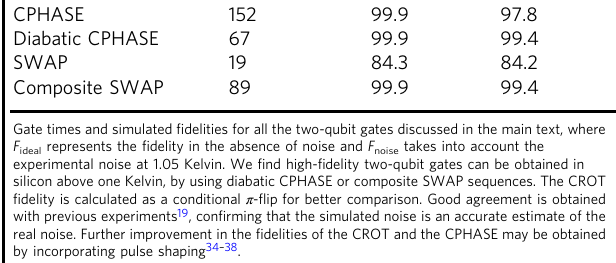
(cid:1) (cid:1) (cid:3) (cid:3) (cid:1) (cid:1) with a π pulse on f 2 . Traces in b correspond to ramp times 0, 16, 33, 49, and 67 ns. to the ""